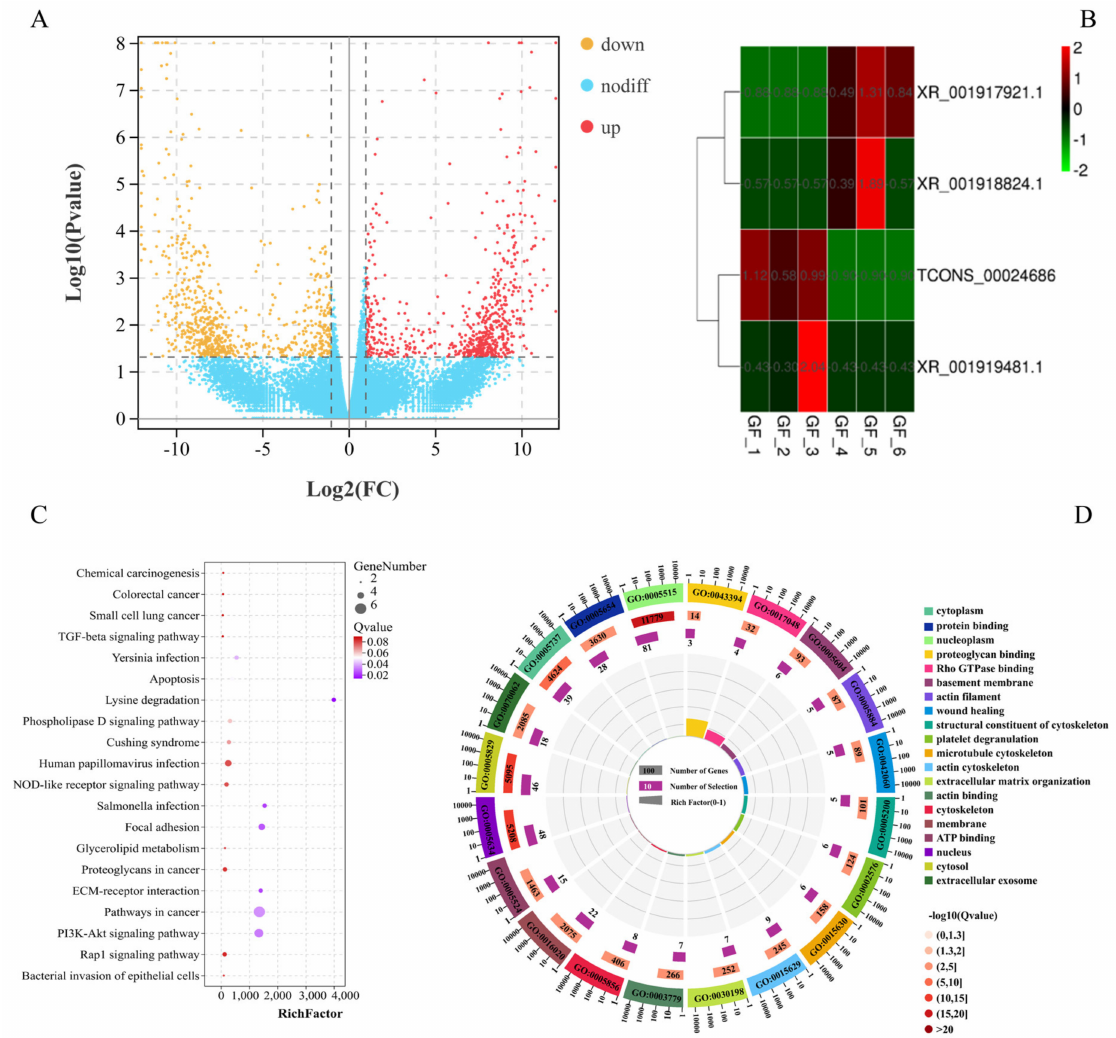
Figure 1. Functional analysis of DEmRNAs and DElncRNAs between the LFs and SFs of Dazu black goat: ( A ), volcano plot of 128 DEmRNAs; red represents up-regulated expression and orange represents down-regulated expression; ( B ), clustering heat map of 4 DElncRNAs; red represents up-regulated expression and green represents down-regulated expression; ( C ), top 20 pathways of KEGG enrichment analysis; and ( D ), top 20 terms of GO enrichment